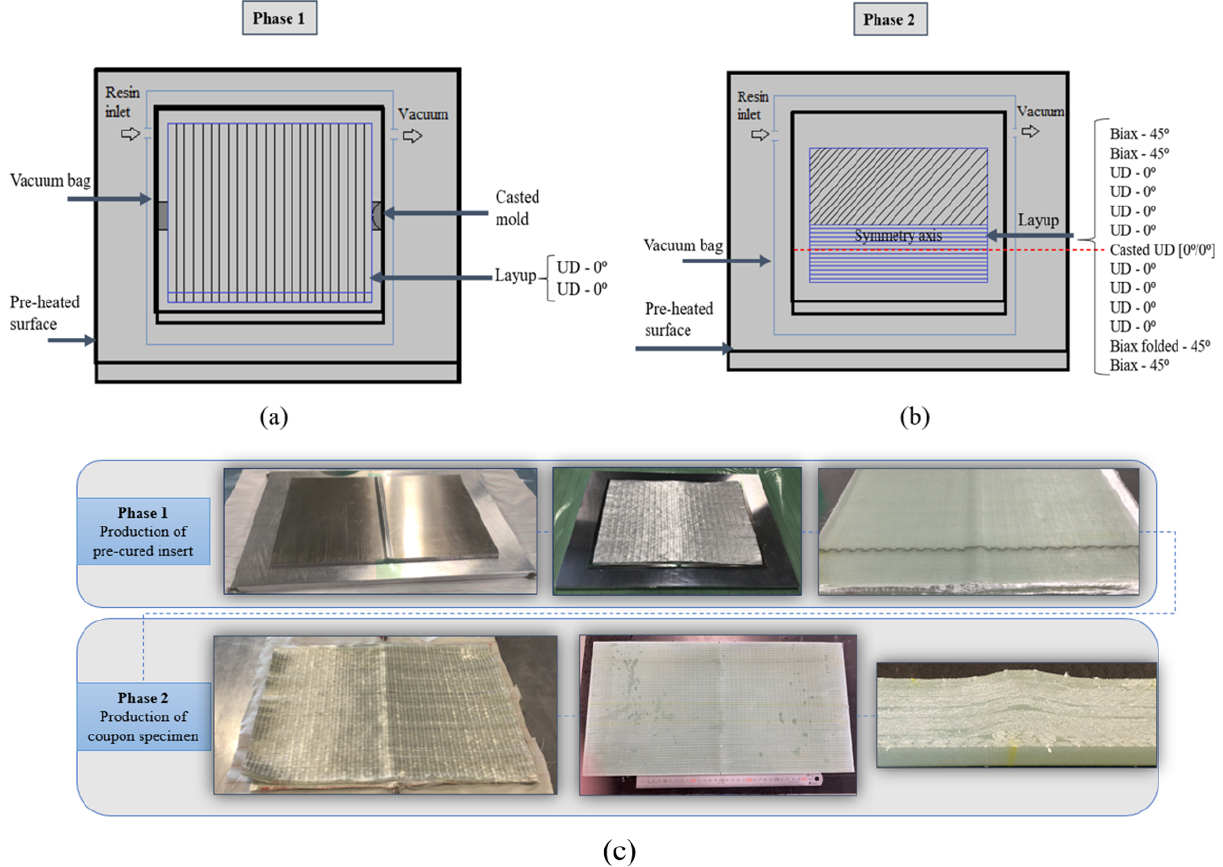
Figure 4. Production phases for the artificial wrinkle defect: (a) schematics of production table for phase 1 with VARI of double UD plies resulting in a pre-cured insert for phase 2. (b) Schematics of the VARI in phase 2 in which the complete laminate is assembled with the pre-cured insert from phase 1 leading to the coupon specimen. (c) Image fluxogram indicating the production steps in phase 1 and phase 2. Table 2. Elastic properties for the GFRP and epoxy material. Elastic